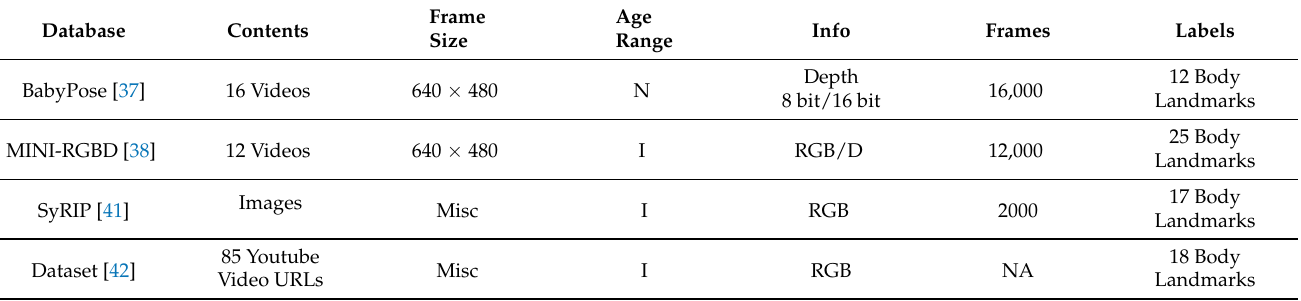
Table 1. Main properties of publicly available datasets. N stands for Newborns, I for Infants and T for Toddlers, Misc for Miscellaneous, NA for Not Applicable, U for